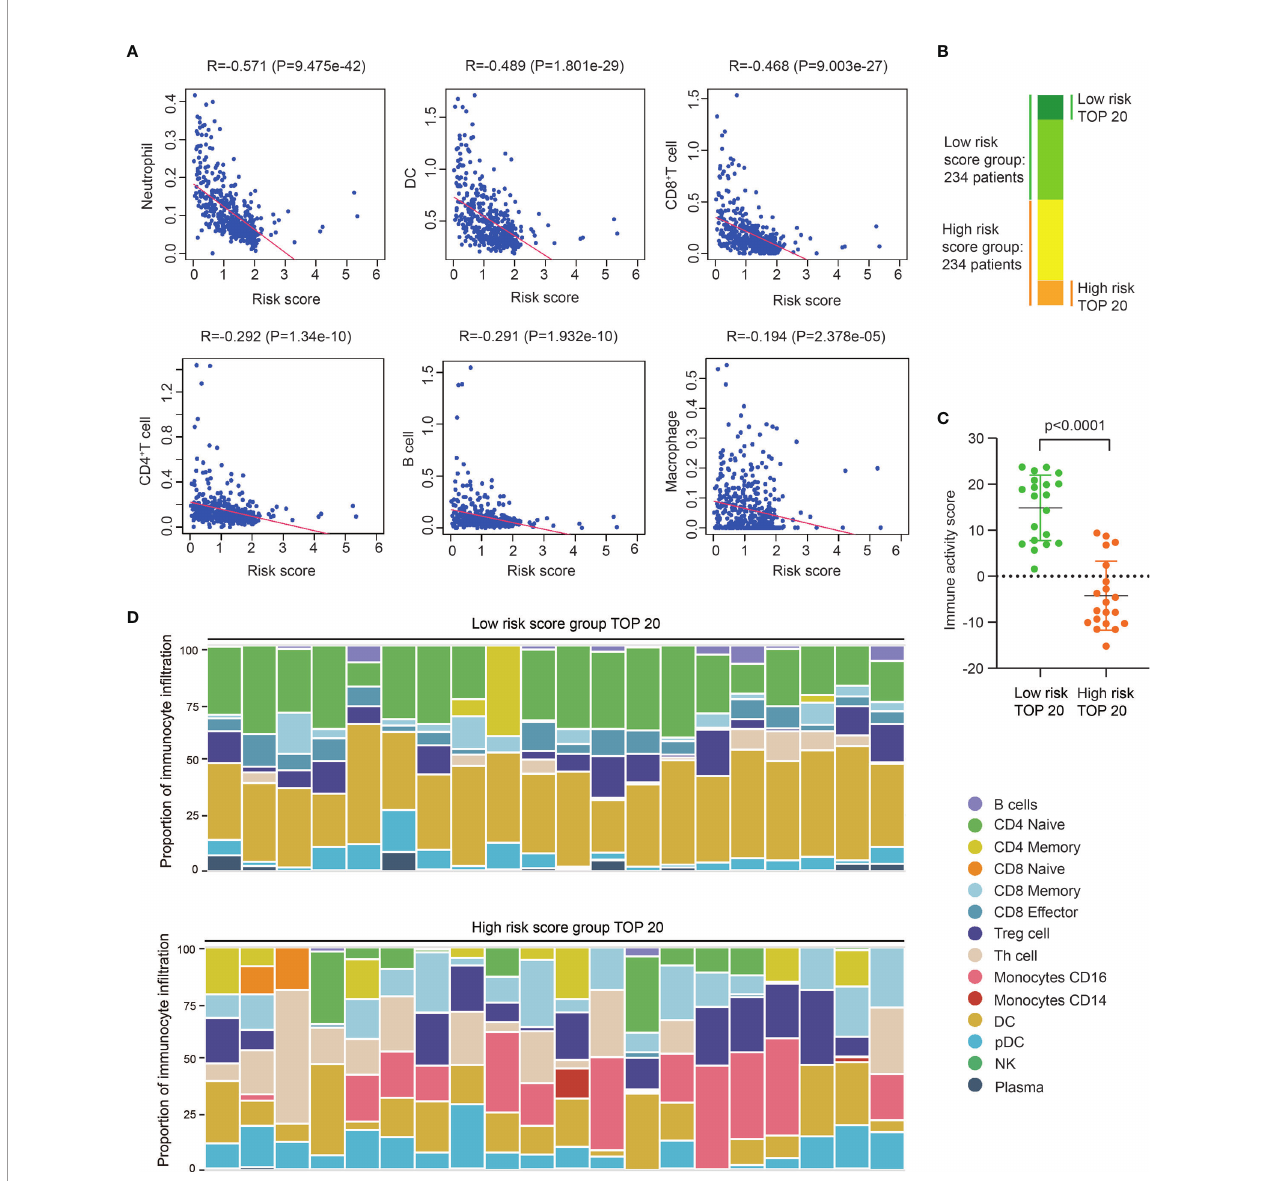
FIGURE 3 | High risk score indicates low immunocyte in fi ltration and weak immune activity in SKCM. (A) Correlation analysis between risk score and different immunocyte in fi ltration, including Neutrophil, DC, CD8 + T cell, CD4 + T cell, B cell, and macrophage, and immunocyte in fi ltration data of different SKCM samples is downloaded from TIMER database. (B) The groups of SKCM samples used for immune activity and immune-in fi ltration analysis. (C) Immune activity of TOP20 low risk SKCM samples and TOP20 high risk SKCM samples in TIP analysis (t test, P<0.0001). (D) Immunocyte composition of TOP20 low risk SKCM samples and TOP20 high risk SKCM samples in TIP